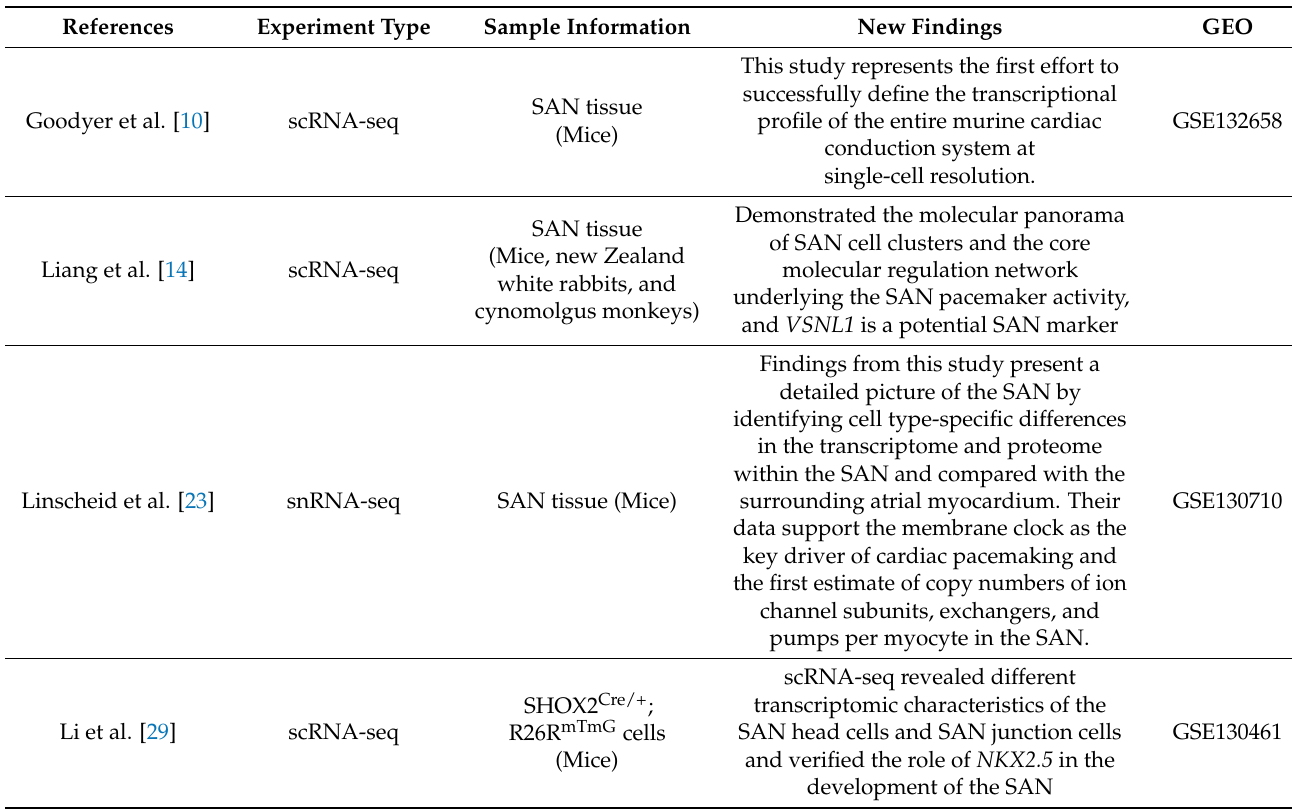
Table 1. Molecular profiling of the